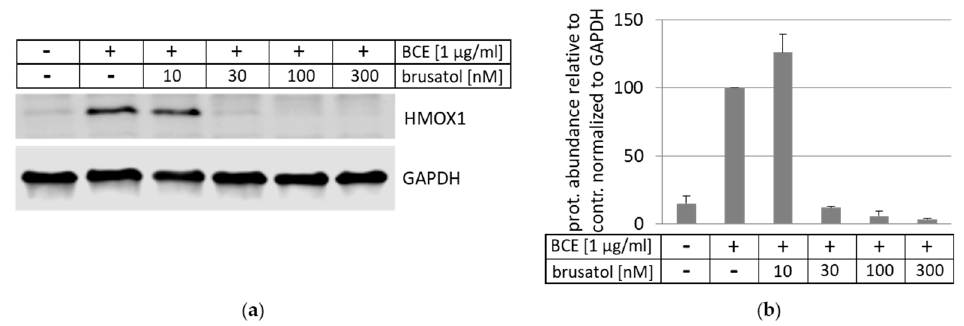
Figure 6. Effect of NRF2 inhibitor brusatol on BCE-induced HMOX1 expression. ( a ) HeLa cells were treated without or with BCE (1 µg/mL; 24 h; indicated by -/+) in the absence or presence of the NRF2 inhibitor brusatol (10 nM, 30 nM, 100 nM, 300 nM; 24 h). HMOX1 expression was examined by Western blot analysis and normalization to GAPDH protein. One representative Western blot of three independent experiments with HeLa cells is shown. ( b ) HMOX1 protein abundance was quan- tified relative to a control (BCE-treated cells in absence of brusatol were set to 100%) and normalized to GAPDH. The data were presented as mean values with standard deviation from three independ- ent experiments.